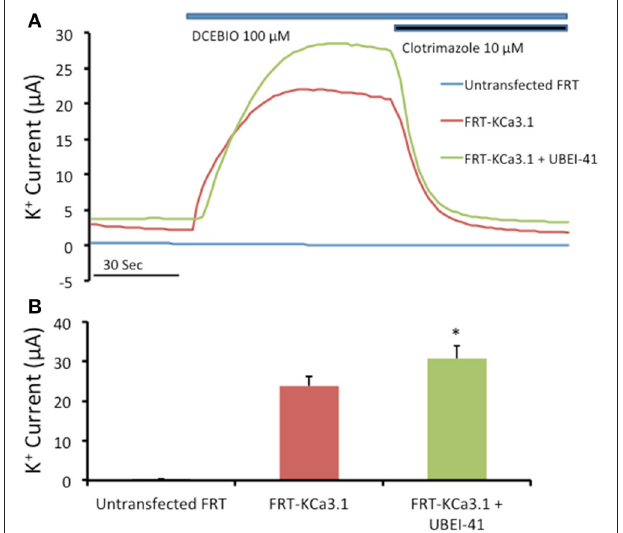
FIGURE 5 | The effect of UBEI-41 on current of the KCa3.1-BLAP cells. (A) A representative trace of UBEI-41 treated FRT-KCa3.1-BLAP cell line. FRT-KCa3.1 cells were grown on Snapwell TM filter inserts then subjected to Ussing chamber experiments. The KCa3.1 specific activator DCEBIO (100 µ M) was applied to the cells that stimulated a K + current due to the opening of FRT-KCa3.1 channels. Clotrimazole (10 µ M) was applied to inhibit KCa3.1 current. With the UBEI-41 (50 µ M) treatment after 1 h, the DCEBIO sensitive K current was significant larger than the non-treated cells, with an averaged difference of 7 ± 1 µ A. (B) Quantitation bar graph of the average DCEBIO sensitive K + current of each tested condition. When stimulated with DCEBIO, control FRT-KCa3.1 cells exhibited an average current of 24 ± 2 µ A (red bar) whereas current of UBEI-41-treated FRT-KCa3.1 cells was 31 ± 3 µ A (green bar). Untransfected FRT cells did not respond to DCEBIO or clotrimazole (blue trace, Figure 5A ). * UBEI-41 treated cells showed statistically significant ( P ≤ 0.05, n = 4) increase of DCEBIO sensitive K + current than non-treated